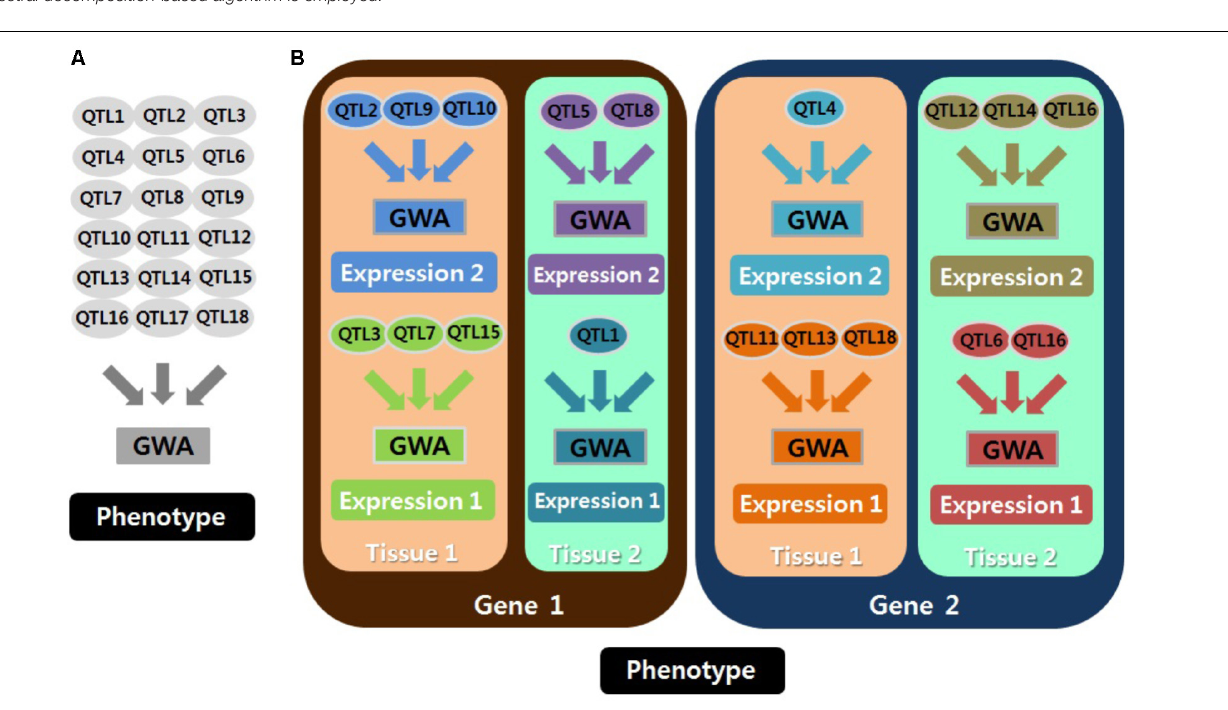
FIGURE 1 | Schematic concepts for analyzing quantitative trait locus (QTL) associated with phenotypes (A) and with gene expression (B) . Each genome-wide association analysis (GWAS) is presented in a different color. Many GWAS should be conducted for QTL associated with gene expression. Thus, employing a mixed model is important because every GWA requires a different genomic similarity matrix, and the cellular environment for gene expression is largely the result of genetic effects. Expression 1 and expression 2 are distinguished by different kinds or stages of expression (e.g., RNA expression and protein expression).